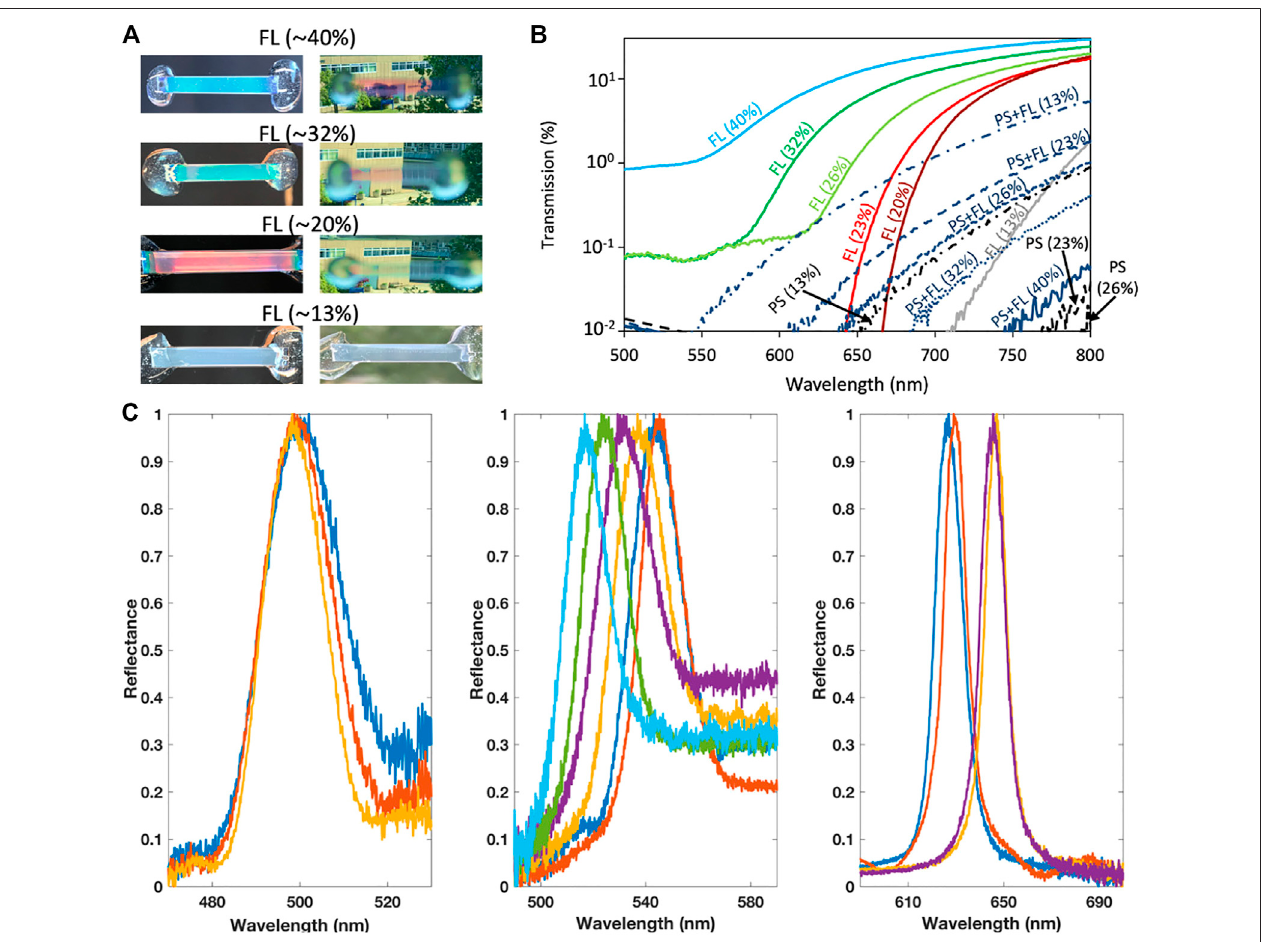
FIGURE 2 | (A) Photographs of fl at cuvettes containing aqueous suspensions of about 196 nm large FL particles at different concentrations, taken in re fl ection (right)andtransmission(left). (B) TransmissionspectrameasuredusingaUV-Visspectrometeroverapathlengthof1 cmcontainingdifferentvolumefractionsofFL,FL+ PSandonlyPSparticles.Thenumbersinparenthesesindicatethev/vconcentrationofcolloids. (C) Normalizedre fl ectivitymeasuredatdifferentpositionsinthe(left)blue (middle) green and (right) red sample of the FL suspensions shown in (A) . The re fl ection peaks of the blue sample occur around 495 – 500 nm, those of the green sample vary between 510 and 560 nm, and the red sample has various re fl ection peaks located between 615 and 650 nm.